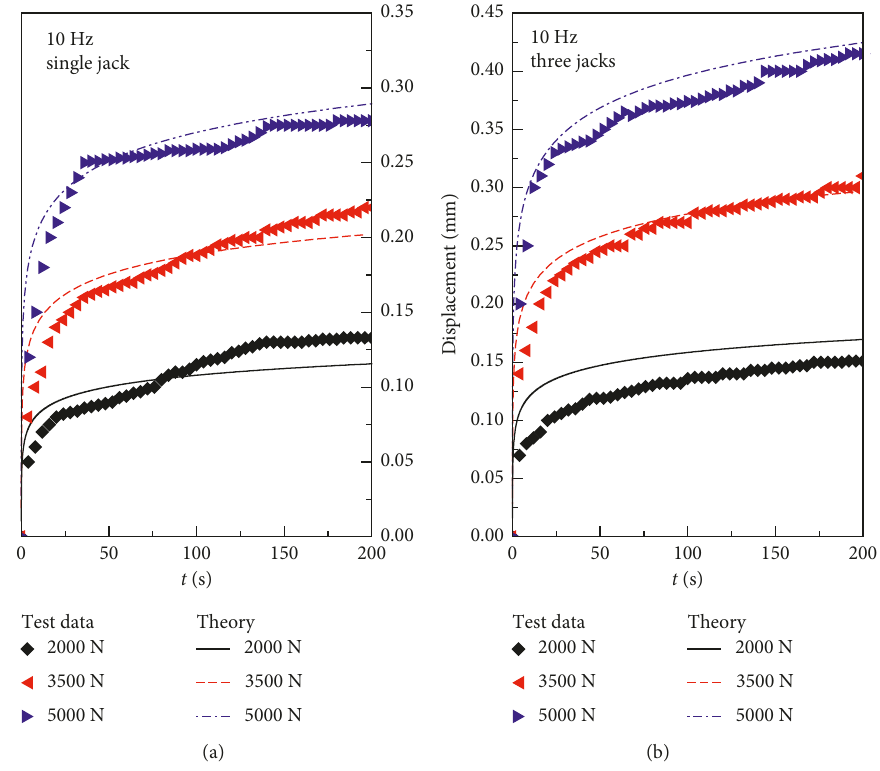
Figure 6: Displacement versus time curves under different excitation loads (gravel): (a) single jack and (b) three